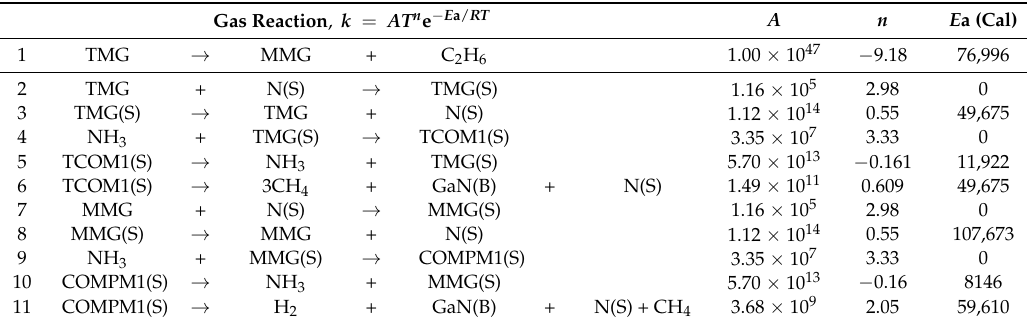
Table 6. New model for GaN